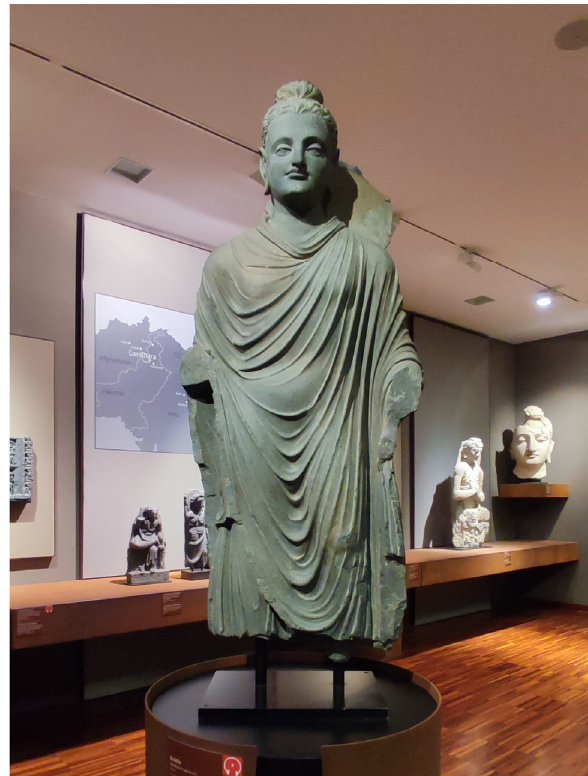
Figure 1 . Buddha statue of Gandhara, II century b.C., Museum of Oriental Art (MAO) in Turin.